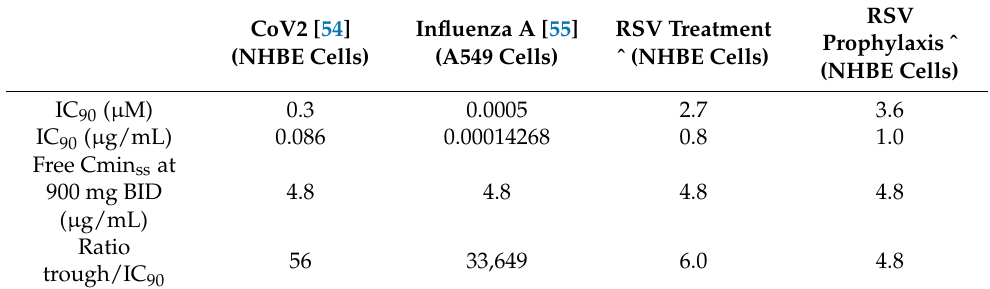
Table 2. Probenecid free drug concentrations at trough and target IC 90 values for CoV2, flu, and